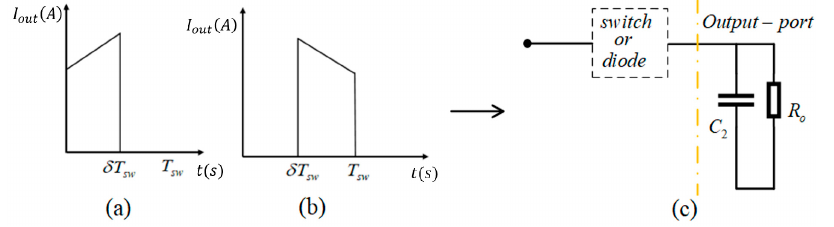
Figure 4. Positive pulsed output-port current component ( a ) active switch current, ( b ) diode current and ( c ) equivalent circuit diagram.